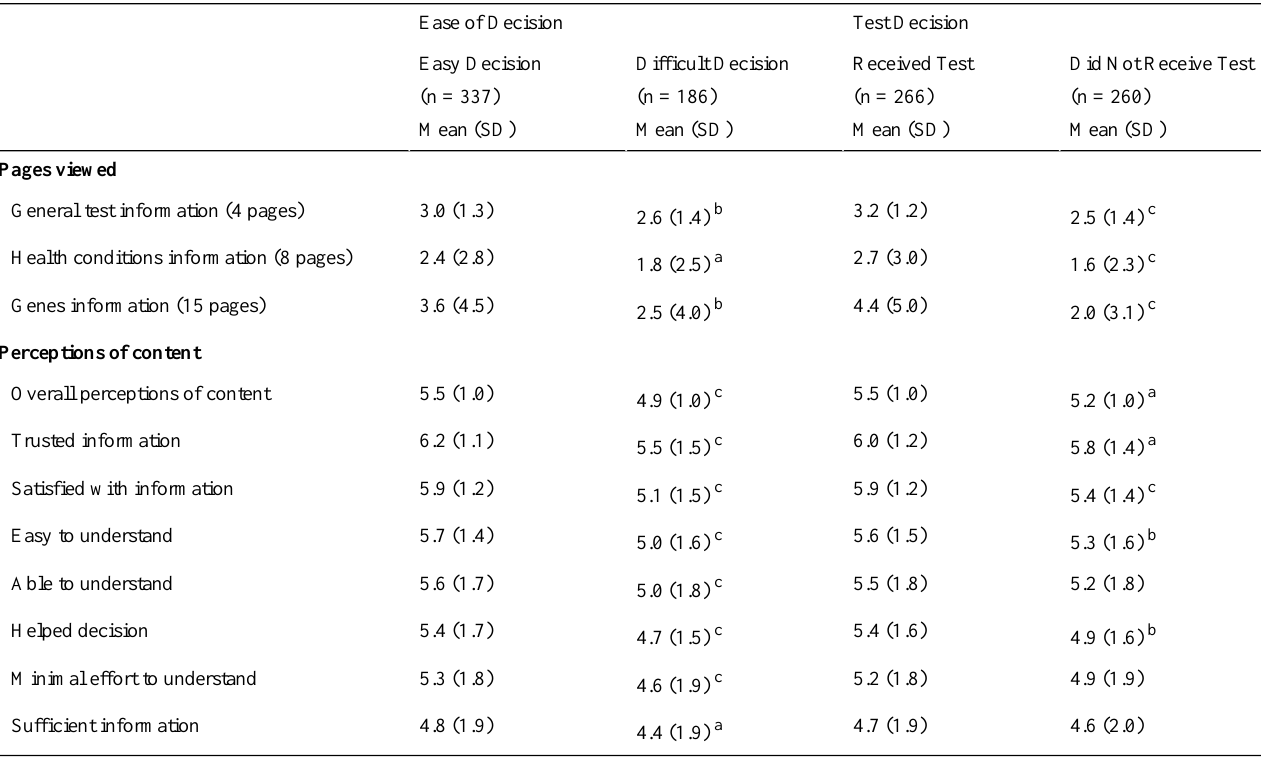
Table 1. Association of website content viewed and ratings of content with decision outcomes (n =